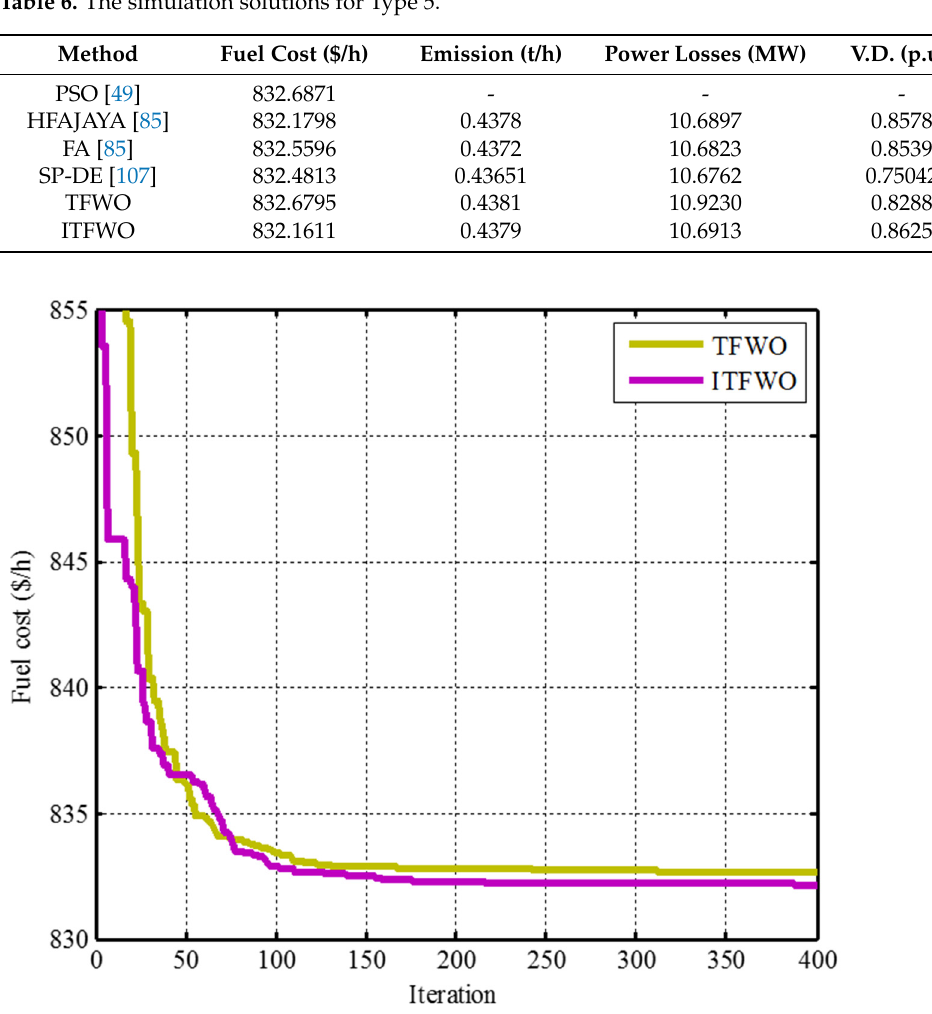
Figure 7. Optimization process for Type 5.